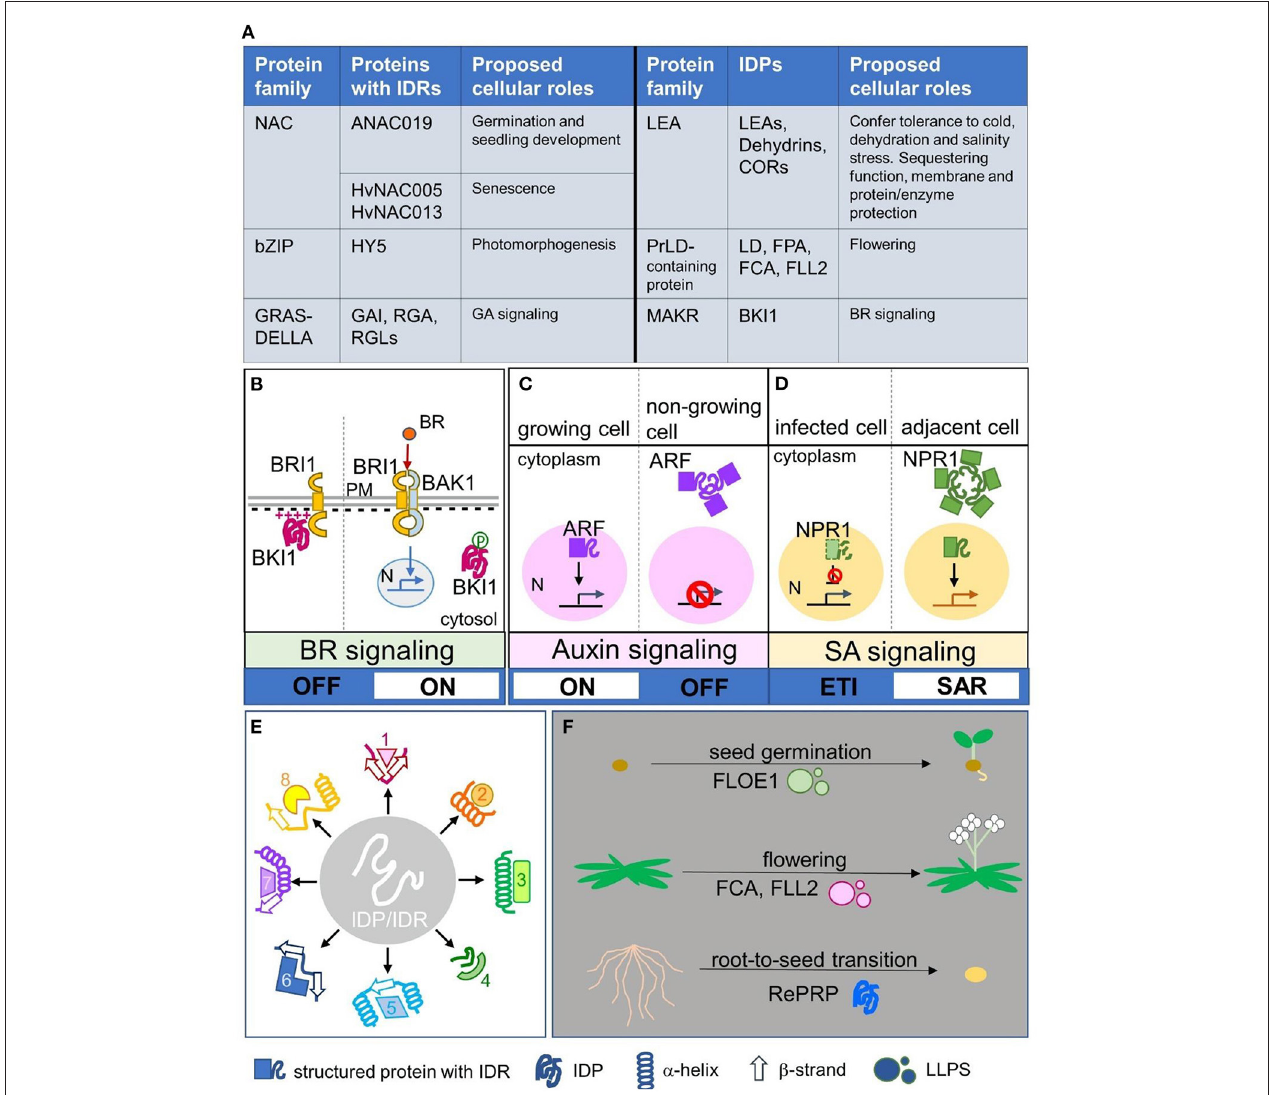
FIGURE 1 | Plant IDP/IDR members and their spatial regulation, broad specificity, and switch of signaling and physiological status. (A) Typical examples of plant protein families with IDP members and proteins with IDRs, including their proposed cellular roles. (B) A case of spatial regulation of IDPs modulated by electrostatic interaction and post-translational modification. Intrinsically disordered BKI1 associated with the plasma membrane by its disordered cationic region and inhibited the formation of BR receptors (BRI1 and BAK1). Phosphorylation of this region causes electrostatic repulsion to release BKI1 from the plasma membrane into the cytosol; thus BRI1 and BAK1 can form active BR receptors and promote downstream BR signaling. (C,D) Two cases showing spatial regulation of IDRs via forming biomolecular condensates. (C) The nuclear–cytoplasmic compartmentation of ARF mediates auxin signaling turning on or off. In actively growing cells, ARF was present in the nucleus and auxin signaling was activated, whereas in non-growing cells, ARF formed condensates via its IDRs and was retained in the cytoplasm; thus auxin signaling was inactivated. (D) The nuclear–cytoplasmic compartmentation of NPR1 mediates SA signaling to trigger the ETI or SAR program. In infected cells, the ETI program is promoted to activate programmed cell death, whereas the inhibitor NPR1 is degraded in the nucleus. In adjacent cells, nucleus-localized NPR1 triggers the SAR program, whereas cytoplasmic NPR1 forms biomolecular condensates to inhibit proteins involved in programmed cell death. (E) IDPs/IDRs may adopt various secondary conformations such as α -helixes or β -strands when interacting with different partners, which generate broad specificity. (F) Three cases showing that protein phase transition controls physiological phase transition. Disordered FLOE1 senses water content and controls seed germination. Disordered FCA and FLL2 form LLPS to control flowering, a phase transition from the vegetative phase to reproductive phase. Intrinsically disordered rice RePRP enables root-to-seed transition as an adaptation response to water deficit stress. IDPs/IDRs: intrinsically disordered proteins/regions; NAC: NO APICAL MERISTEM, ATAF, CUP-SHAPED COTYLEDON; bZIP: basic domain/leucine zippers; HY5: LONG HYPOCOTYL 5; GRAS: GIBBERELLIC ACID INSENSITIVE, REPRESSOR of GAI, SCARECROW; DELLA: Asp-Glu-Leu–Leu-Ala; GAI: GIBBERELLIC ACID INSENSITIVE; RGA: REPRESSOR of GAI; RGL: RGA-LIKE; GA: Gibberellic acid; LEA: